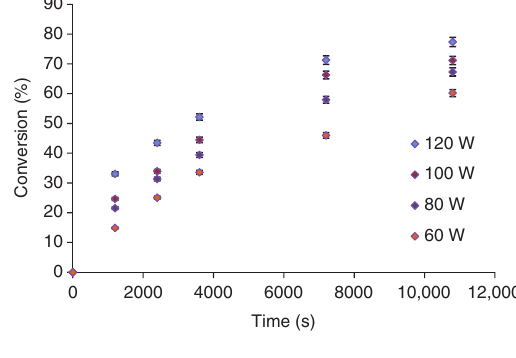
Figure 11 Effect of ultrasonic power on the percentage conversion.